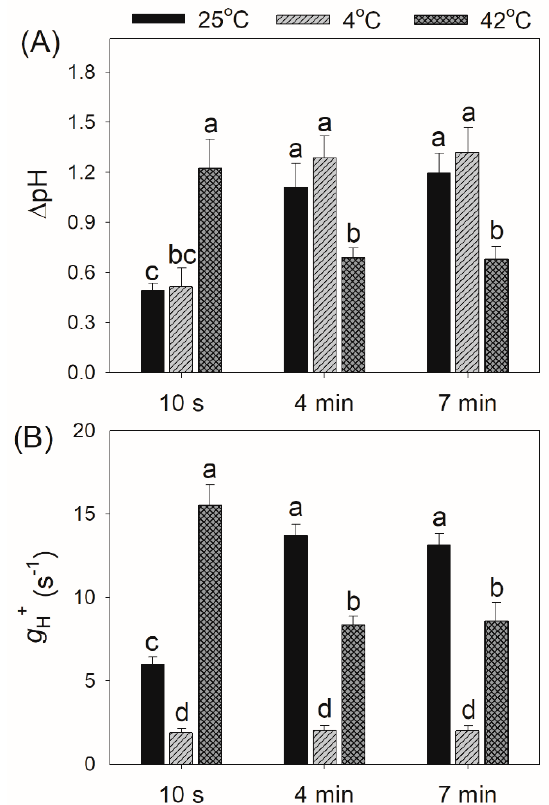
Figure 4. Changes in trans-thylakoid proton gradient ( ∆ pH) ( A ) and chloroplast ATP synthase activity ( g H+ ) ( B ) after transition from dark to actinic light (1455 µ mol photons m − 2 s − 1 ) at 25 ◦ C, 4 ◦ C, and 42 ◦ C. Values are means ± SE ( n = 5). Different letters indicate significant differences among different treatments.